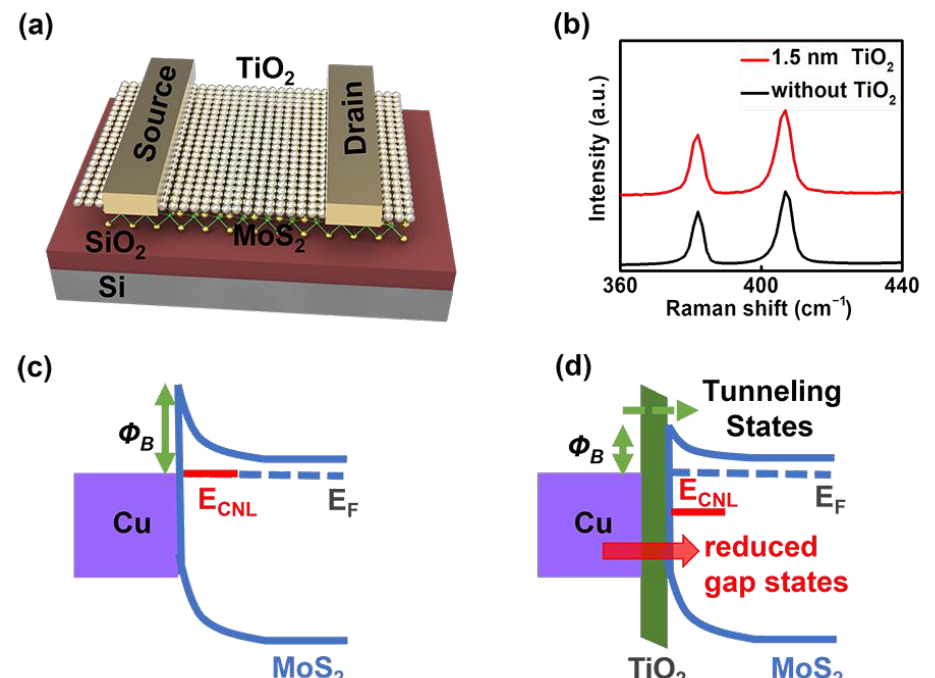
Figure 2. ( a ) Fabrication schematic of the MoS 2 FETs with a TiO 2 interlayer; ( b ) Raman scattering spectra of the multilayer MoS 2 without and with the TiO 2 layer; ( c , d ) band diagrams of the MS structure and MIS structure.